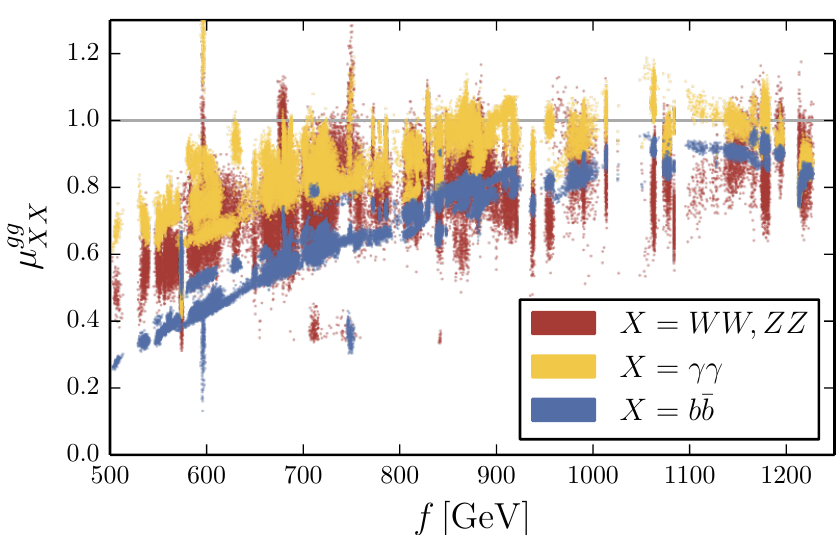
Figure 2 . Modi(cid:12)cations of Higgs signal strengths for di(cid:11)erent decay channels. The SM expectation is given by the gray line as (cid:22) gg = 1. By custodial symmetry, the signal strengths into WW and ZZ are the